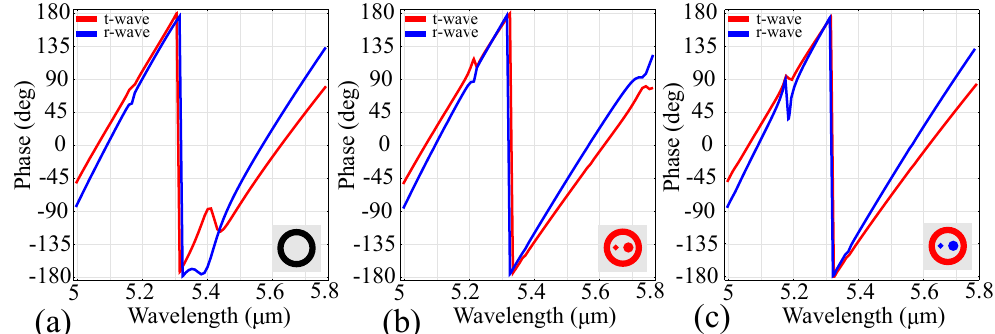
Figure 4. Phase coverage across the window of interest in the reference configuration for: ( a ) the silicon ring; ( b ) the all-silicon configuration; ( c ) the gold-silicon configuration. The configurations are indicated in the insets, with silicon being represented in red and gold represented in